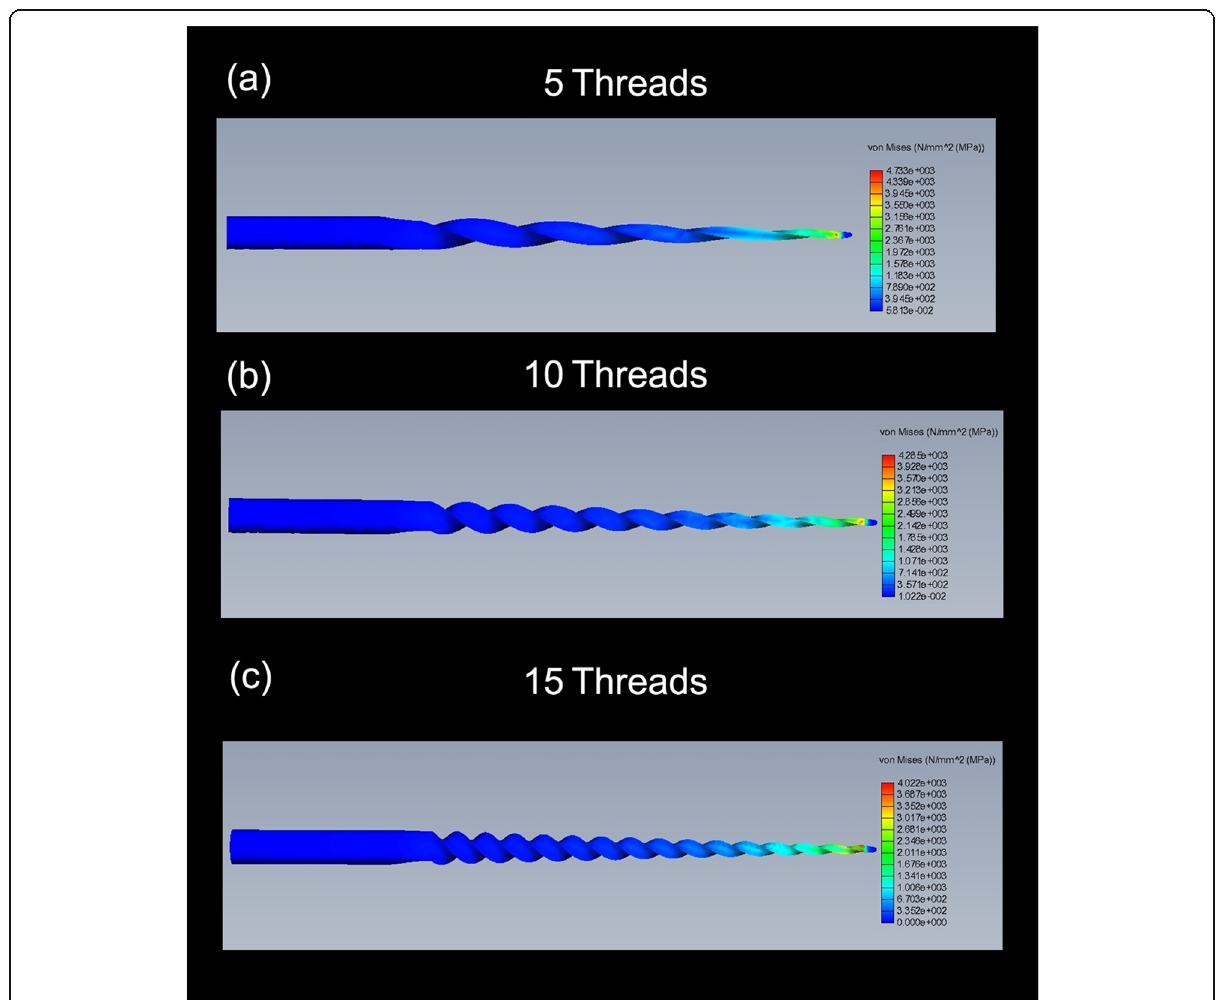
Fig. 6 Stress distribution during torsion of different tested file pitch. a 5 threads. b 10 threads. c 15